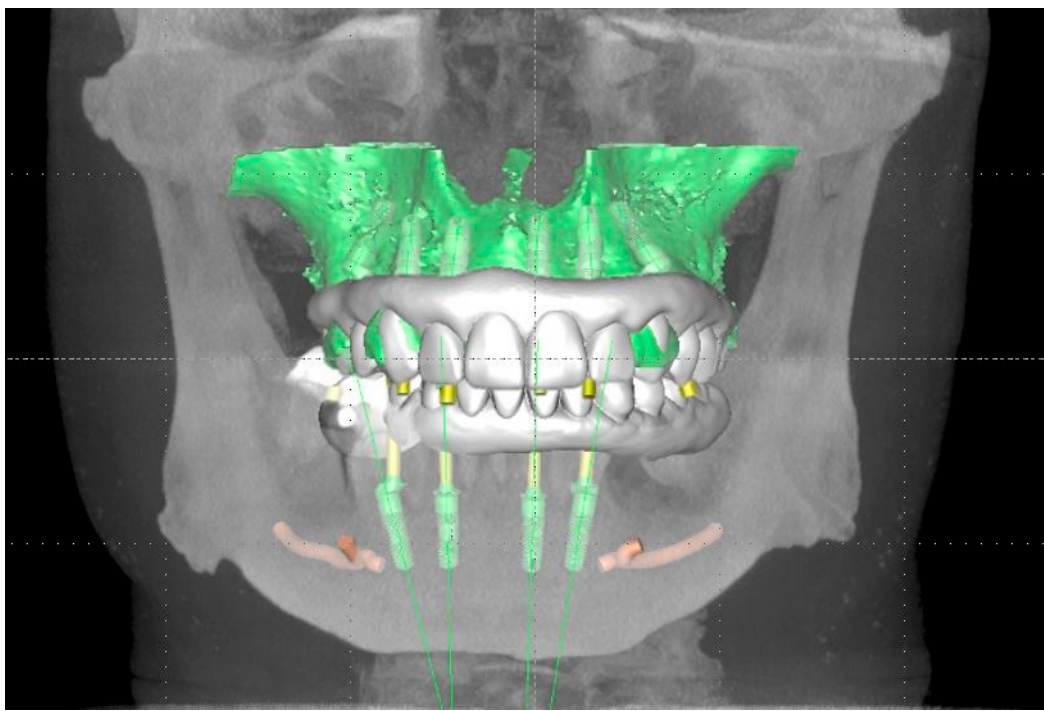
Figure 11. Frontal view of digital planning using the contours of the digital designs of the 3D-printed overlay templates as reference.